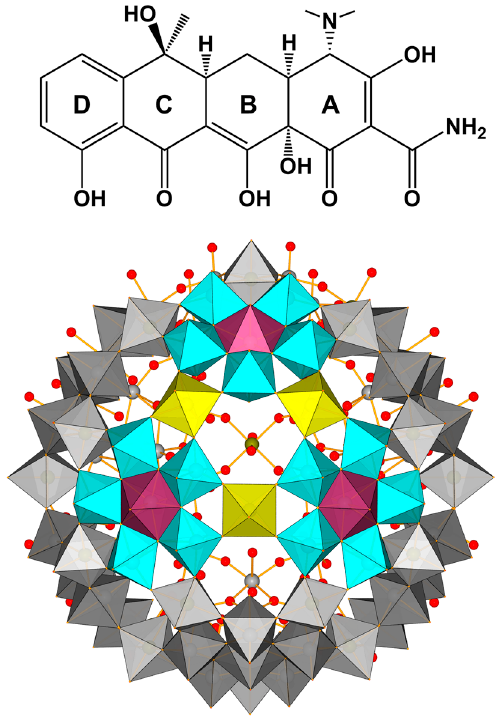
Figure 1. The structure of tetracycline (TC) and Keplerate {Mo 72 Fe 30 }, represented by the frontal part in the form of molybdenum (VI) and iron (III) oxygen polyhedra. Polyhedra code: yellow—FeO 6 ; light blue—MoO 6 ; purple—MoO 7 . Atomic code: yellow—iron; gray—molybdenum; red—oxygen.